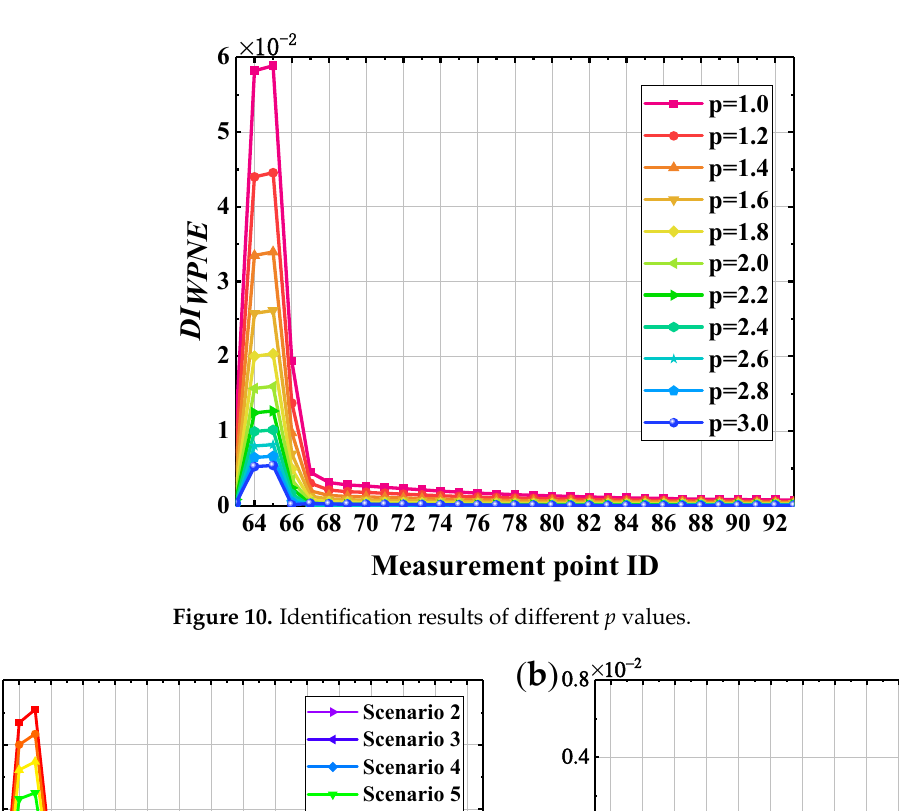
Figure 10. Identification results of different p values.